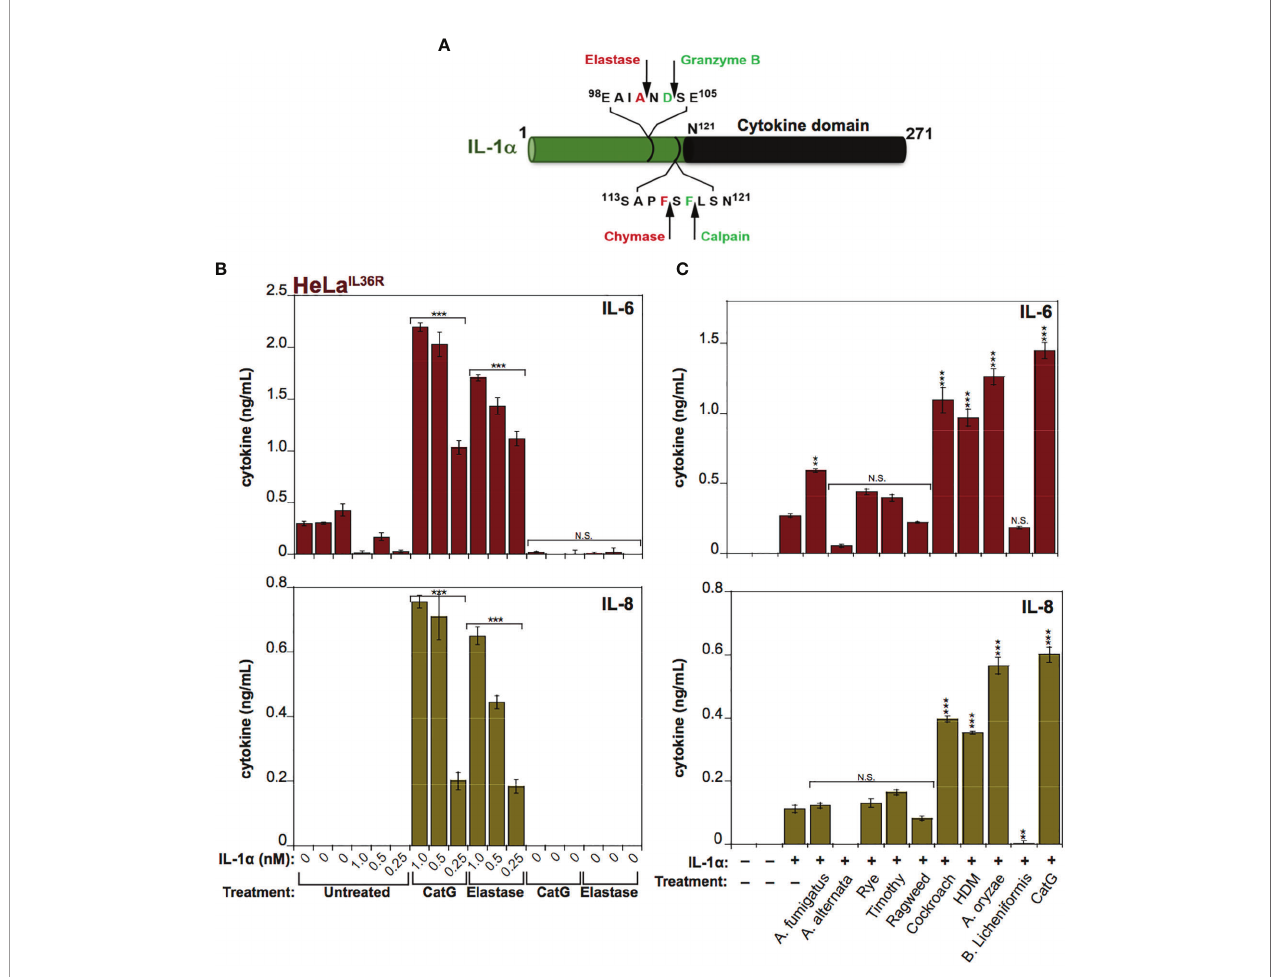
FIGURE 4 | IL-1 a activity is enhanced by exposure to neutrophil-derived proteases as well as several allergen-associated proteases (A) Schematic representation of human IL-1 a with known cleavage sites for elastase, granzyme B, chymase and calpain indicated. (B) HeLa IL-36R cells were stimulated with the indicated concentrations of full-length human IL-1 a , either untreated, or after incubation for 2 h at 37°C with elastase (25 nM) or cathepsin G (25 nM), as shown. After 24h, IL- 6 and IL-8 cytokine concentrations in cell culture supernatants were measured by ELISA. (C) HeLa IL-36R cells were stimulated with full-length human IL-1 a (2 nM), either untreated, or after incubation for 2 h at 37°C with the indicated allergen extracts (10 m g/ml of all allergen extracts was used, with the exception of A. oryzae which was a 1:1000 dilution of stock protease). As a positive control, IL-1 a was activated with 20 nM Cathepsin G. After 24 h, IL-6 and IL-8 cytokine concentrations in cell culture supernatants were measured by ELISA. Error bars represent the mean of triplicate determinations from representative experiments. ***p < 0.001, **p < 0.01, Student ’ s t test. N.S., Not Signi fi